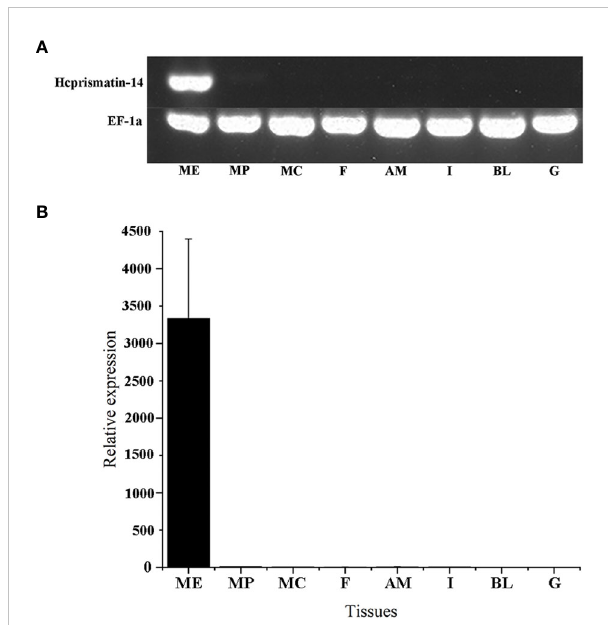
FIGURE 3 RT-PCR and qRT-PCR of Hcprismatin-14 expression in H. cumingii . ME, mantle edge; MP, mantle pallial; MC, mantle center; F, foot; AM, adductor muscle; I, intestines; BL, blood; G, gonad. The housekeeping gene EF-1 a was used as a positive control.